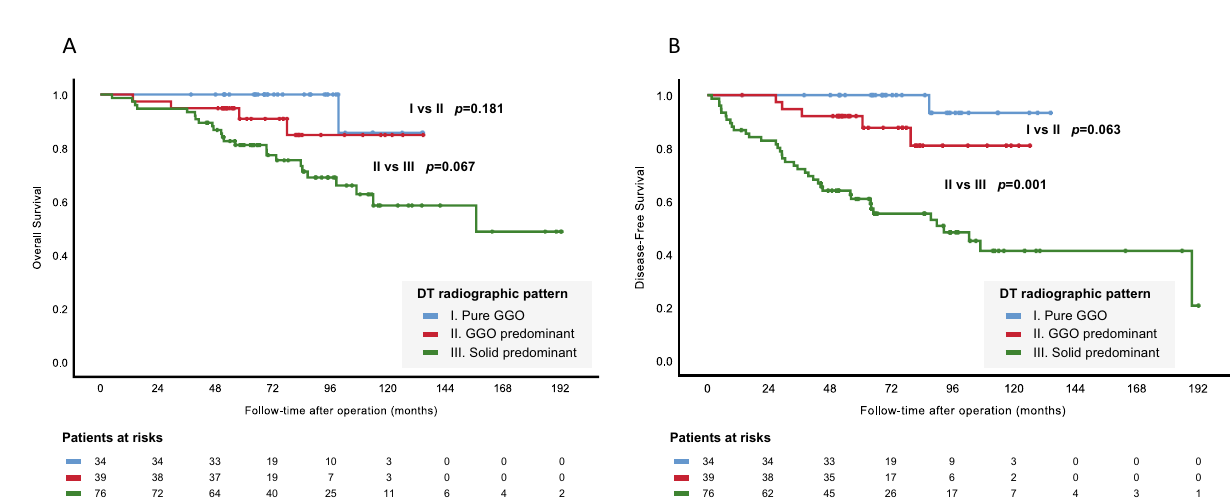
Figure 3. Overall and disease-free survival between different radiologic appearances ( A , B ) of the dominate